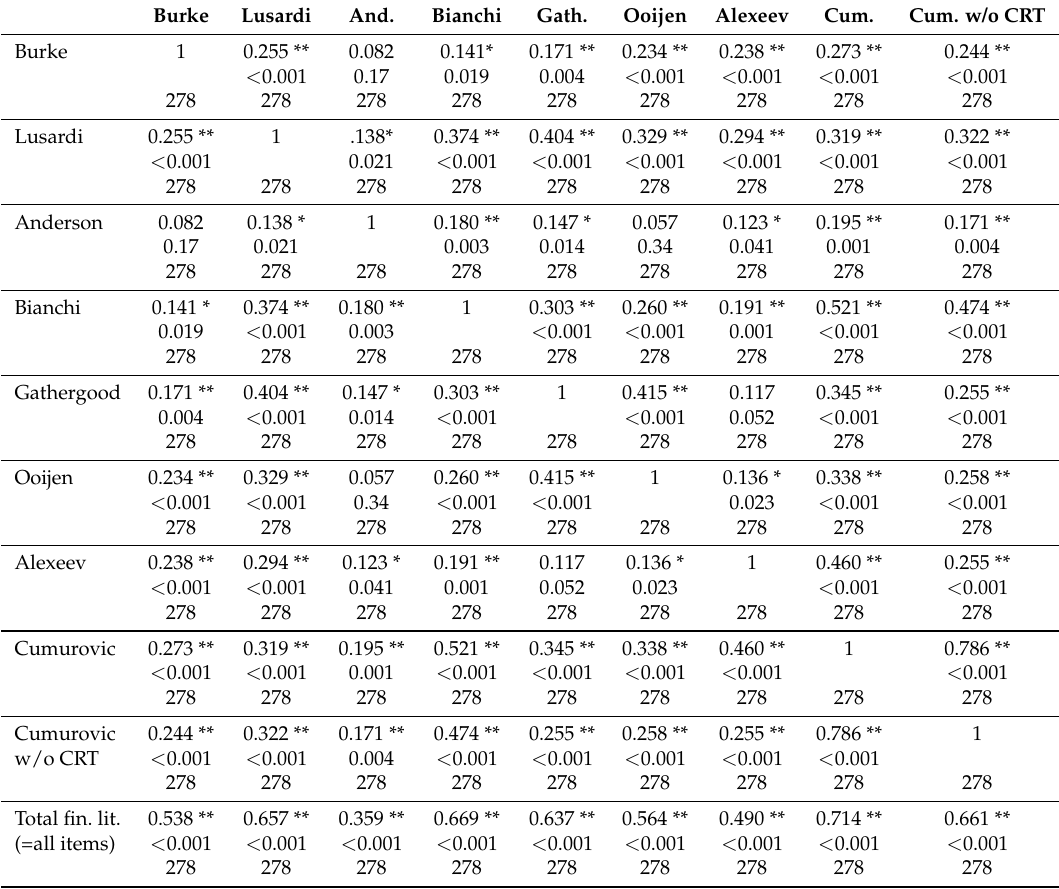
Table 5. Correlations between different financial literacy measures.